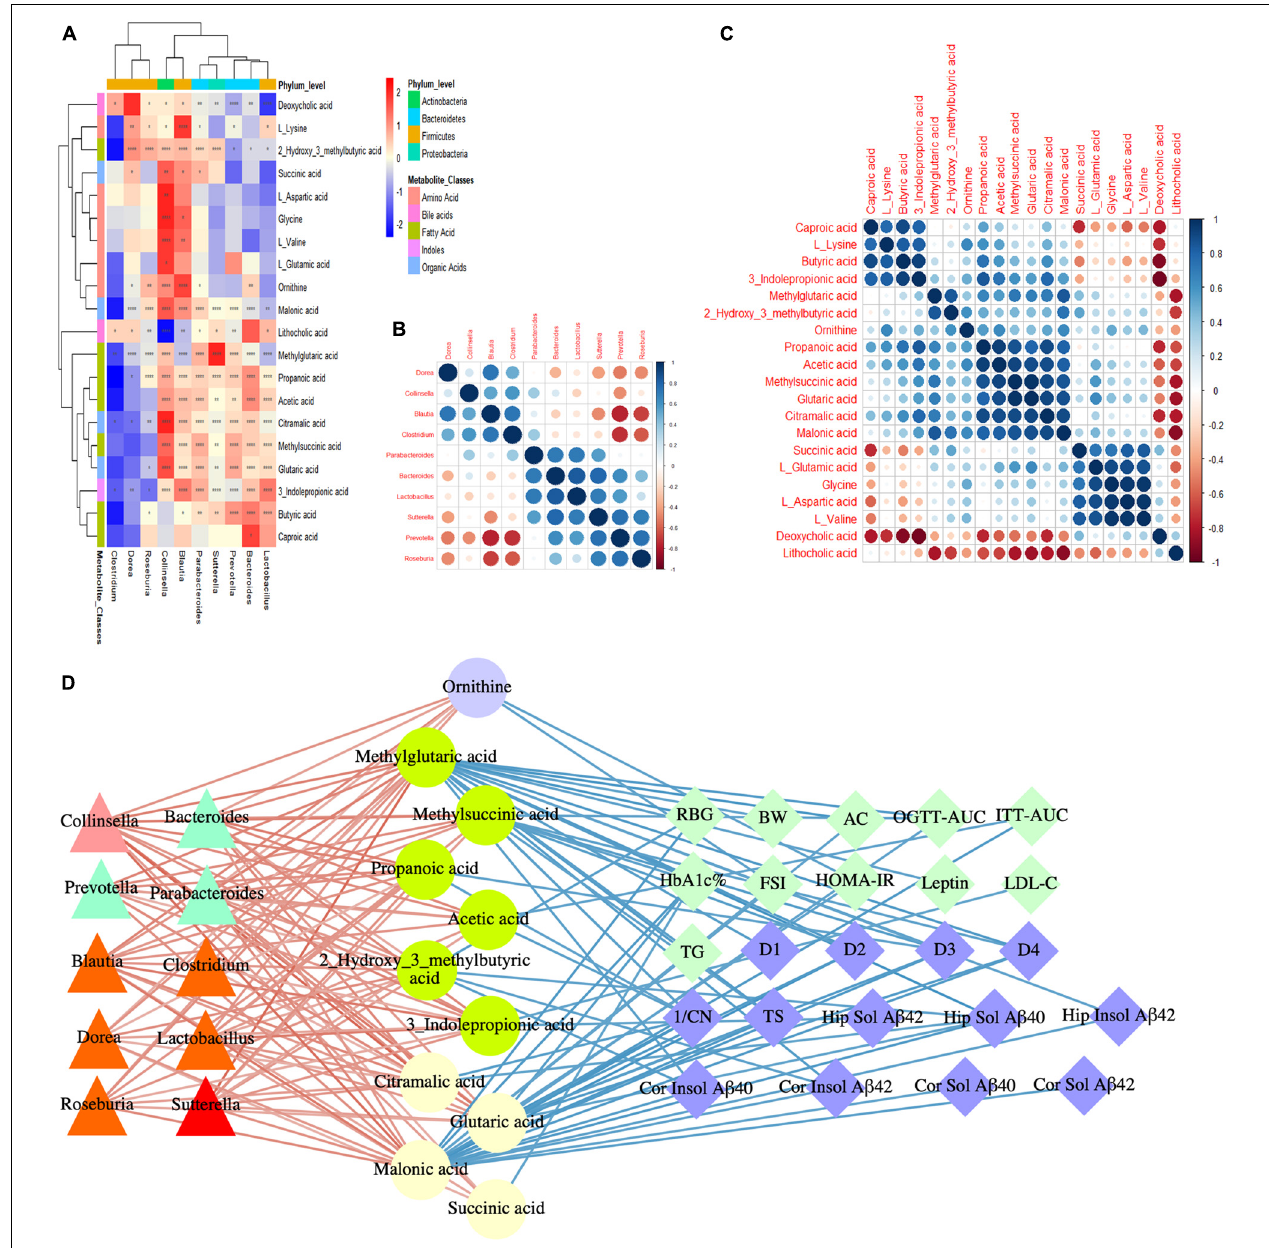
FIGURE 8 | DACD bioinformatics analysis and correlation network construction. (A) Correlation between differential genera and metabolites. (B) Spearman correlation analysis of differential genera. (C) Spearman correlation analysis of differential metabolites. (D) Correlation among bacterial genera (triangle), intestinal metabolites (circle), and DACD phenotypes (diamond). The degree of correlation is shown by the gradient change of red (positive correlation) and blue (negative correlation). ∗ P < 0.05, ∗∗ P < 0.01, ∗∗∗∗ P < 0.0001. RBG, random blood glucose; BW, body weight; AC, abdominal circumference; OGTT-AUC, area under the curve of the oral glucose tolerance test; ITT-AUC, area under the curve of the insulin secretion test; HbA1c%, glycosylated hemoglobin; FSI, fasting serum insulin; HOMA-IR, homeostasis model of assessment for insulin resistance; D1-D4, escape latency during a 4 days training course in the orientation navigation test of Morris water maze test; 1/CN, the reciprocal of crossing number of the original platform location in the spatial exploration test of Morris water maze test; TS, time in searching original platform location in the spatial exploration test of Morris water maze test; Hip, hippocampus; Cor,